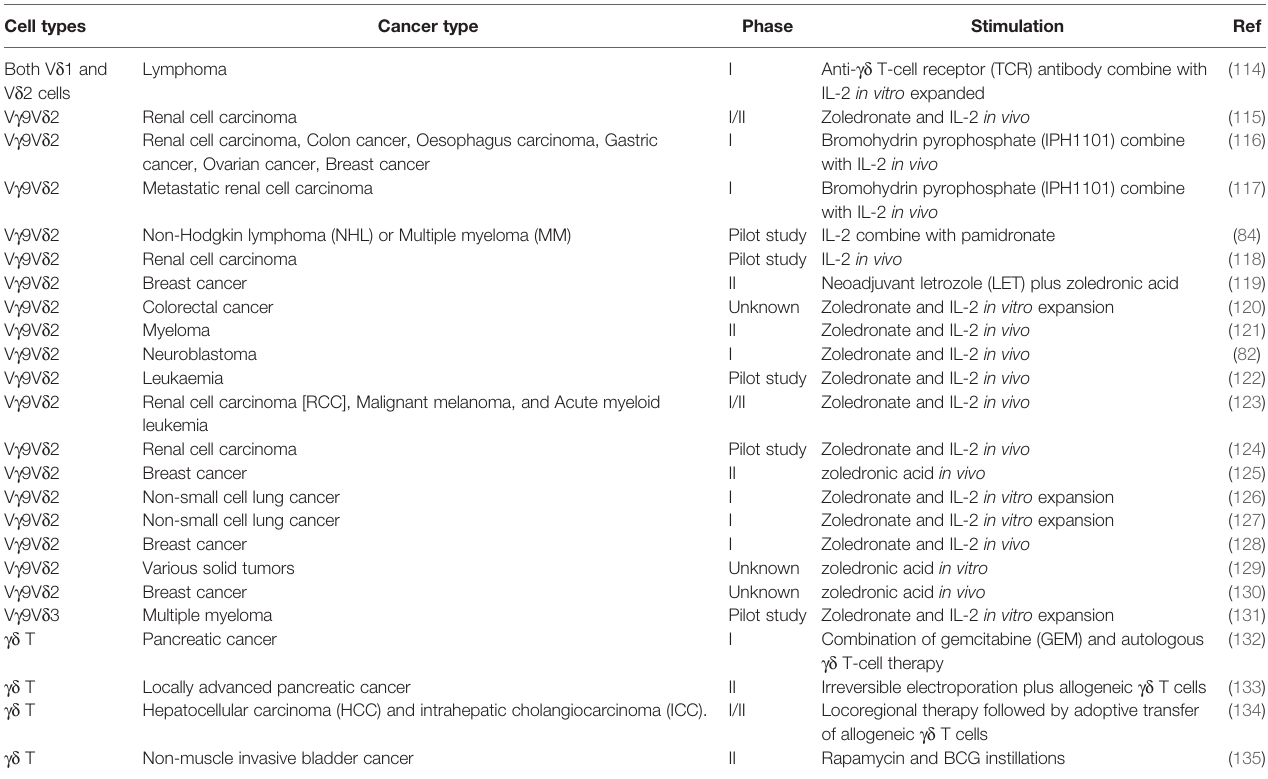
TABLE 2 | Clinical trials of gd T cell-based